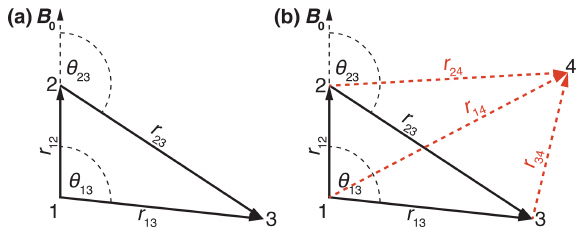
Figure 1. Schematic drawing of the (a) three-spin and (b) four-spin systems used in numerical simulations indicating distances and rela- tive orientations. The red dashed lines indicate out-of-plane vectors to the fourth